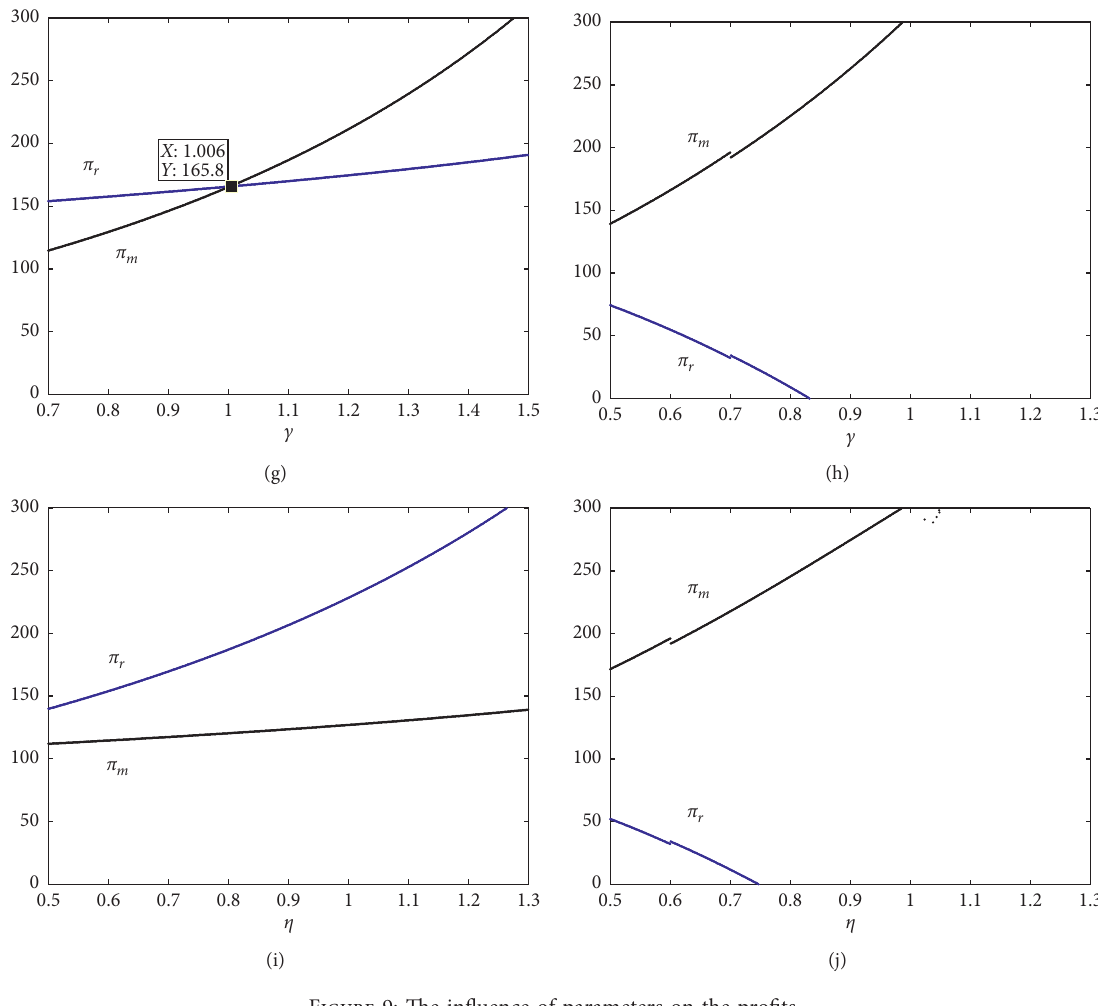
Figure 9: The influence of parameters on the profits.